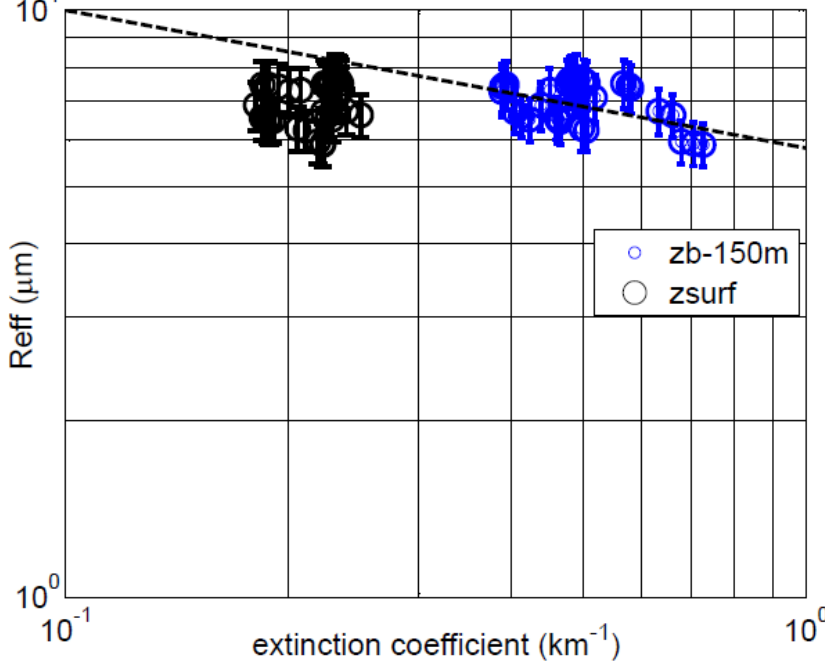
Figure 11. Log-Log plot of Raman lidar extinction below cloud against the cloud droplet effective radius. “zb-150m” (blue circles) indicates the upper air atmospheric column layer which was used in the comparison ( i.e. , 150 m below the cloud base altitude denoted by zb), while 'zsurf' refers to the atmospheric layer closest to the surface (~30